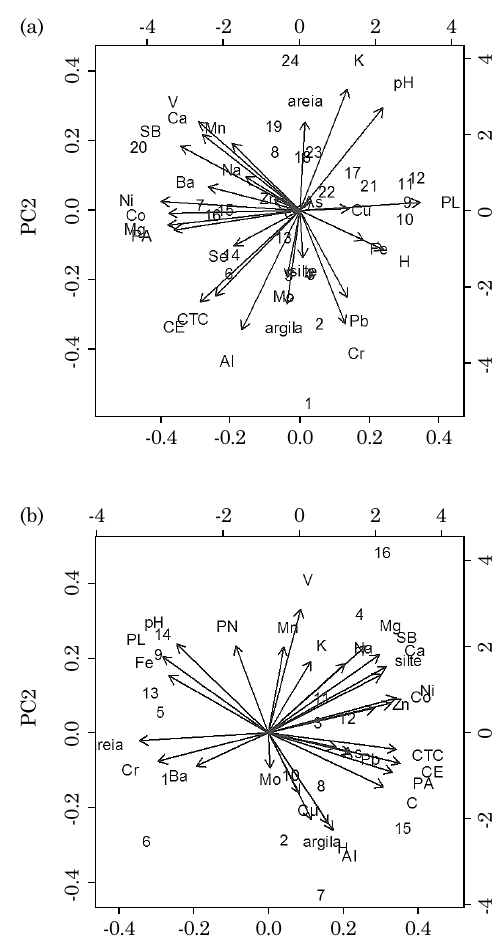
Figura 5. Biplots dos primeiros dois componentes principais obtidos das análises multivariadas. (a) e (b) Biplots referentes à análise de componentes principais dos solos construídos das áreas I, II, IV e VII,